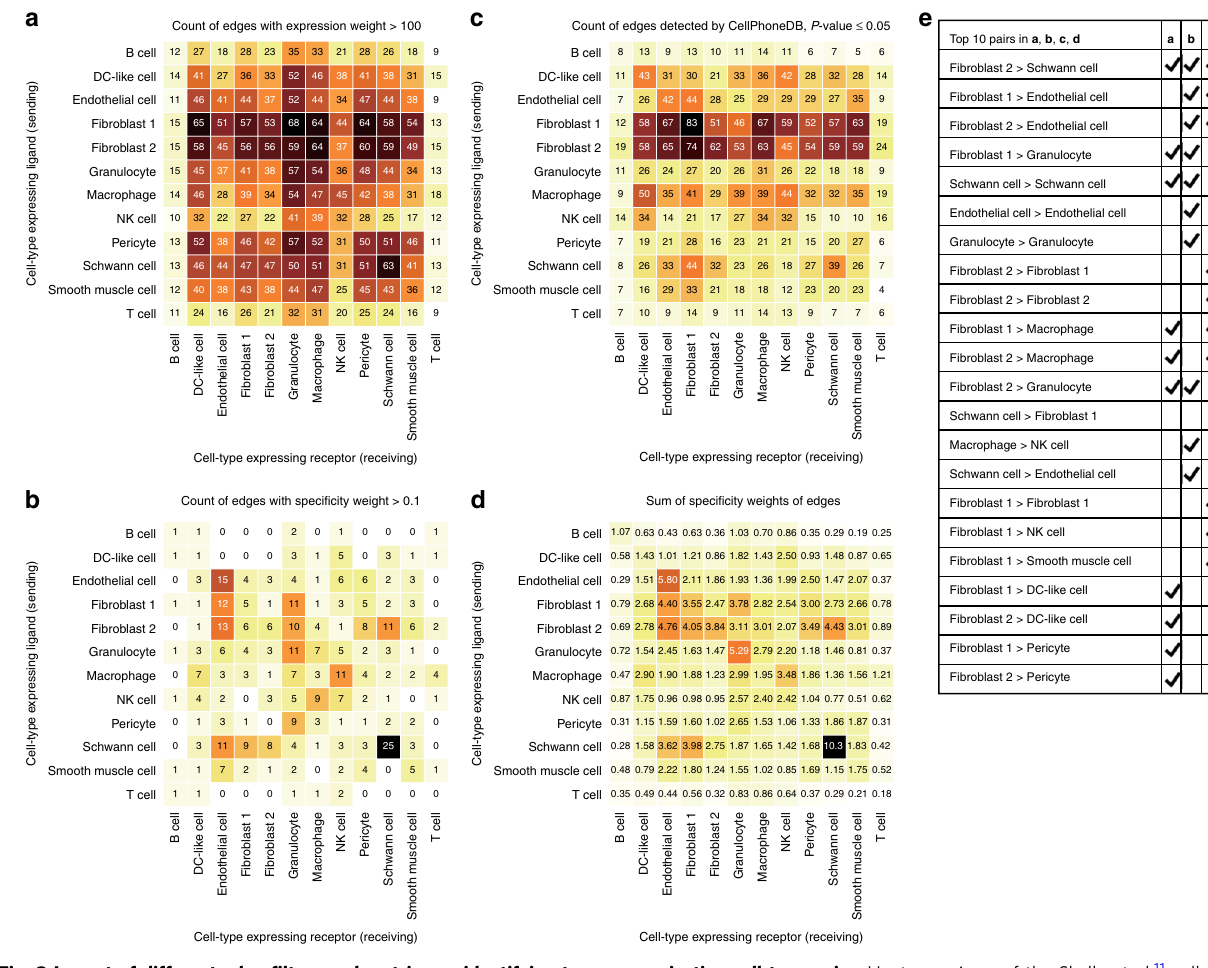
Fig. 3 Impact of different edge fi lters and metrics on identifying top communicating cell-type pairs. Heatmap views of the Skelly et al. 11 cell- connectivity-summary network shown in Fig. 2 after fi ltering ligand – receptor pairs based on a mean-expression weight ( ≥ 100), b speci fi city ( ≥ 0.1) or c p values obtained by using CellPhoneDB 18 ( ≤ 0.05). As an alternative to hard fi ltering the network, view in d is weighted by the sum of the speci fi cities. e Compares the top 10 communicating cell type pairs identi fi ed in a – d